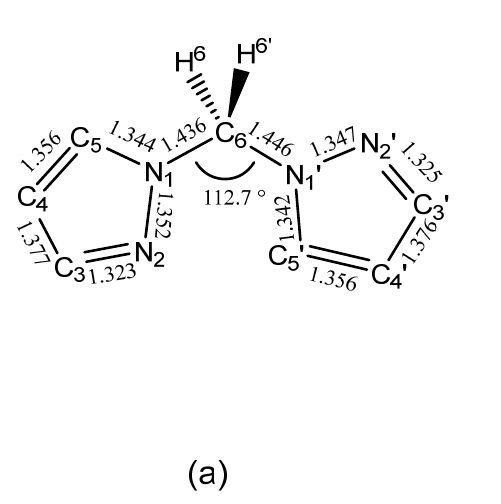
Figure 4. Select bond lengths and angles of ( a ) bis(1 H -pyrazol-1-yl)methane [30] and ( b ) L 1 .